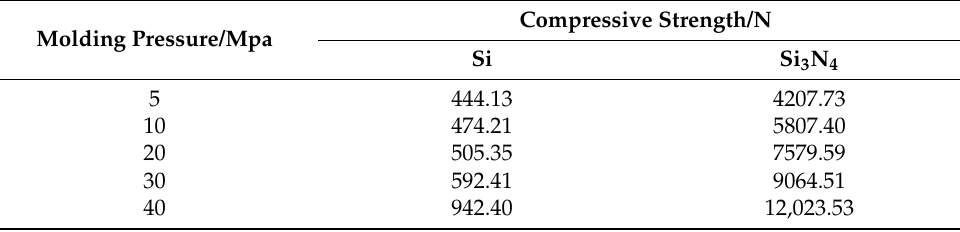
Table 2. The compressive strength of different briquettes under various pressures.